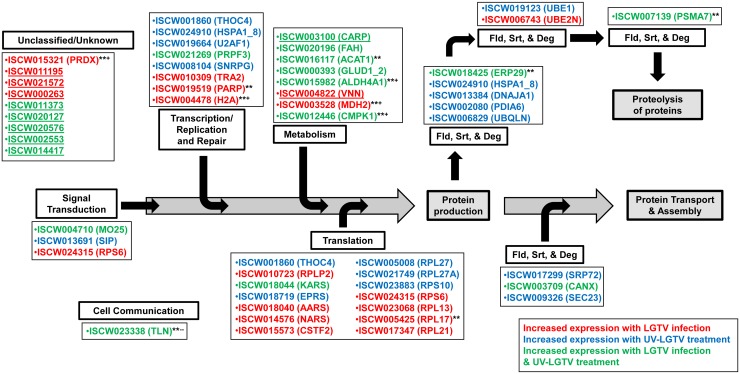
ISE6 proteins with increased expression associate with pathways for protein production, transport, assembly, and proteolysis.The ISCW accession numbers corresponding to proteins identified with increased expression in LGTV-infected and UV-LGTV-treated cells are shown (KEGG abbreviated nomenclature provided as well if available in parentheses). The schematic presents potential mechanisms for LGTV-induced perturbation and increase in cell protein expression. See S5 Table for information on proteins and KEGG protein classes. Underlined proteins denote ISE6 proteins exhibiting increased expression following flavivirus infection not identified before. “Fld, Srt, & Deg” is the folding, sorting, and degradation KEGG pathway. ** denotes ortholog in human [19]; + denotes human ortholog showing increased expression following HCV infection;—denotes human ortholog showing decreased expression following HCV infection. Gray boxes denote cellular protein functions. White boxes denote KEGG pathways.